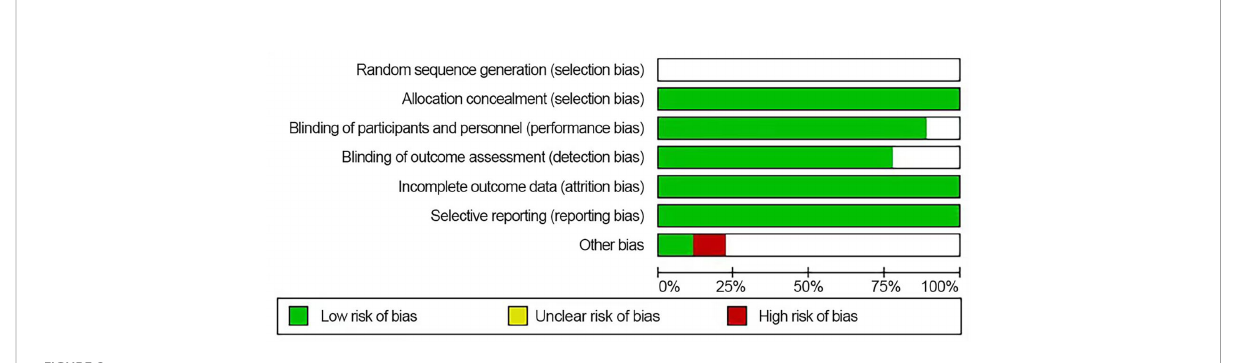
FIGURE 2 The form of literature quality evaluation.